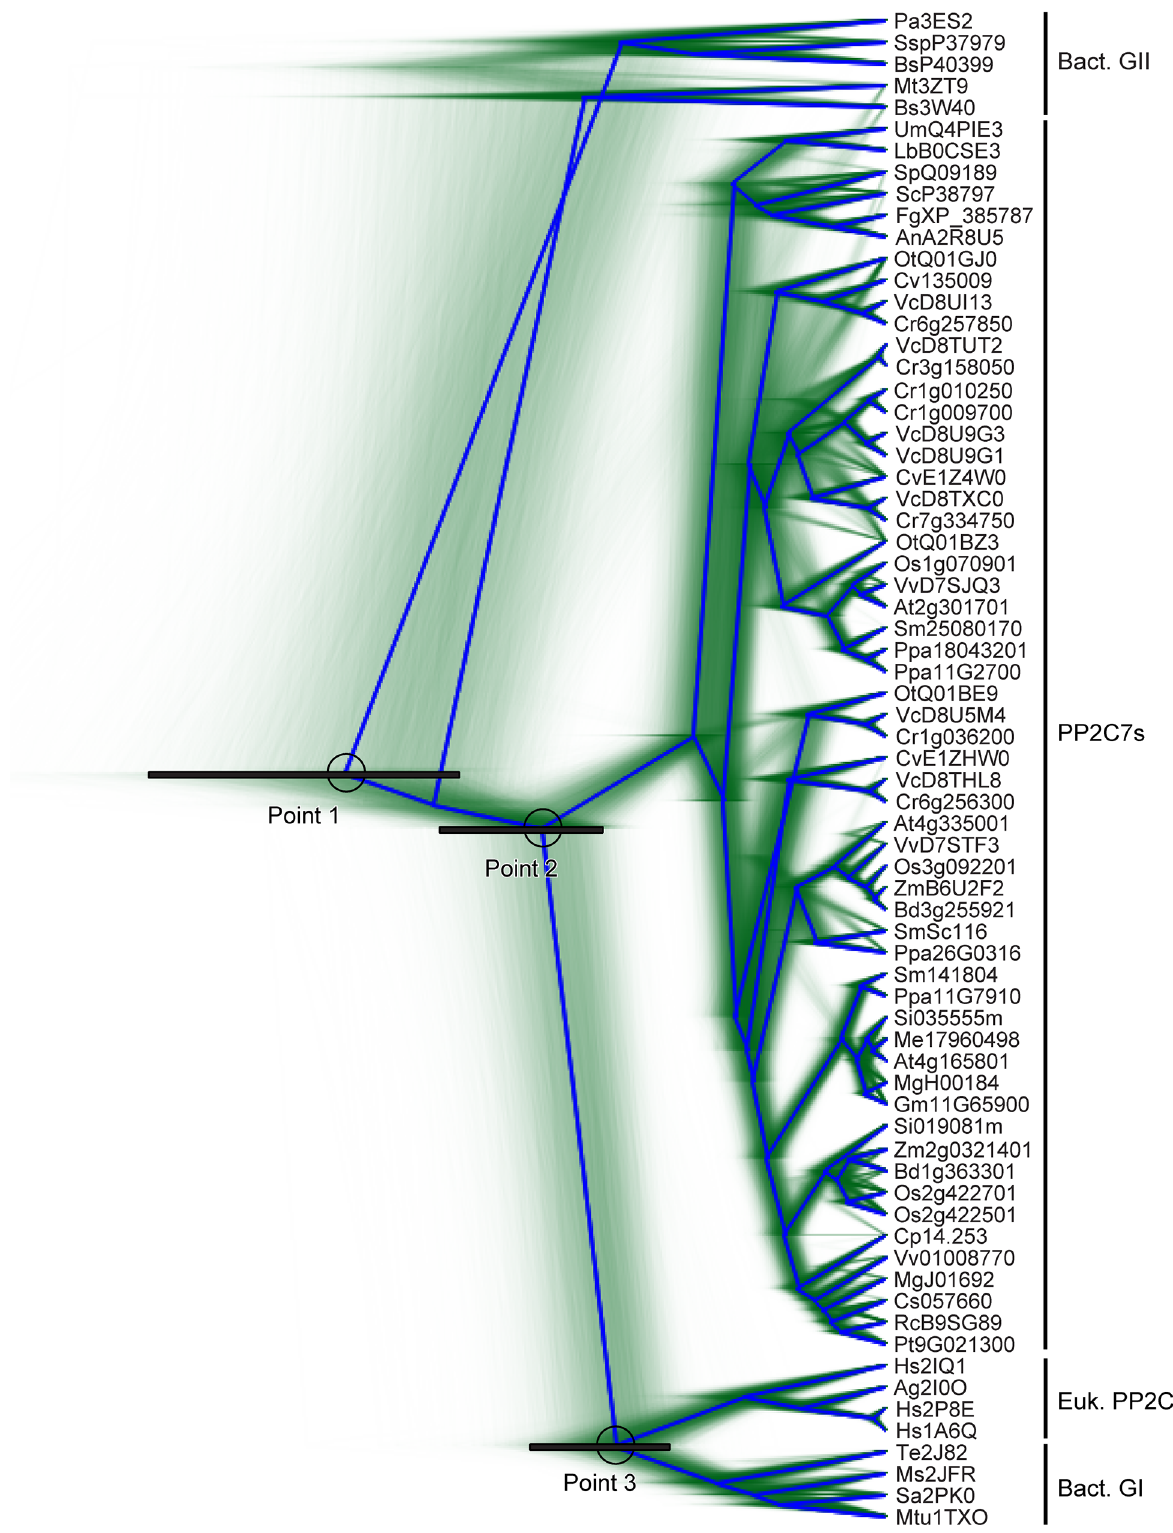
Fig 2. Topological uncertainty in the phylogenetic tree summarizing PP2C sequence evolutionary history. This tree is an alternate display of the same BEAST analysis data used to generate Fig 1. Green lines represent traces of individual trees from amongst the posterior distribution tree sample. In blue is the consensus tree with the highest clade support ( “ root canal ” ). Points 1, 2, and 3 are discussed in the text. Each represents a node with a black bar indicating the 95% high posterior density interval.